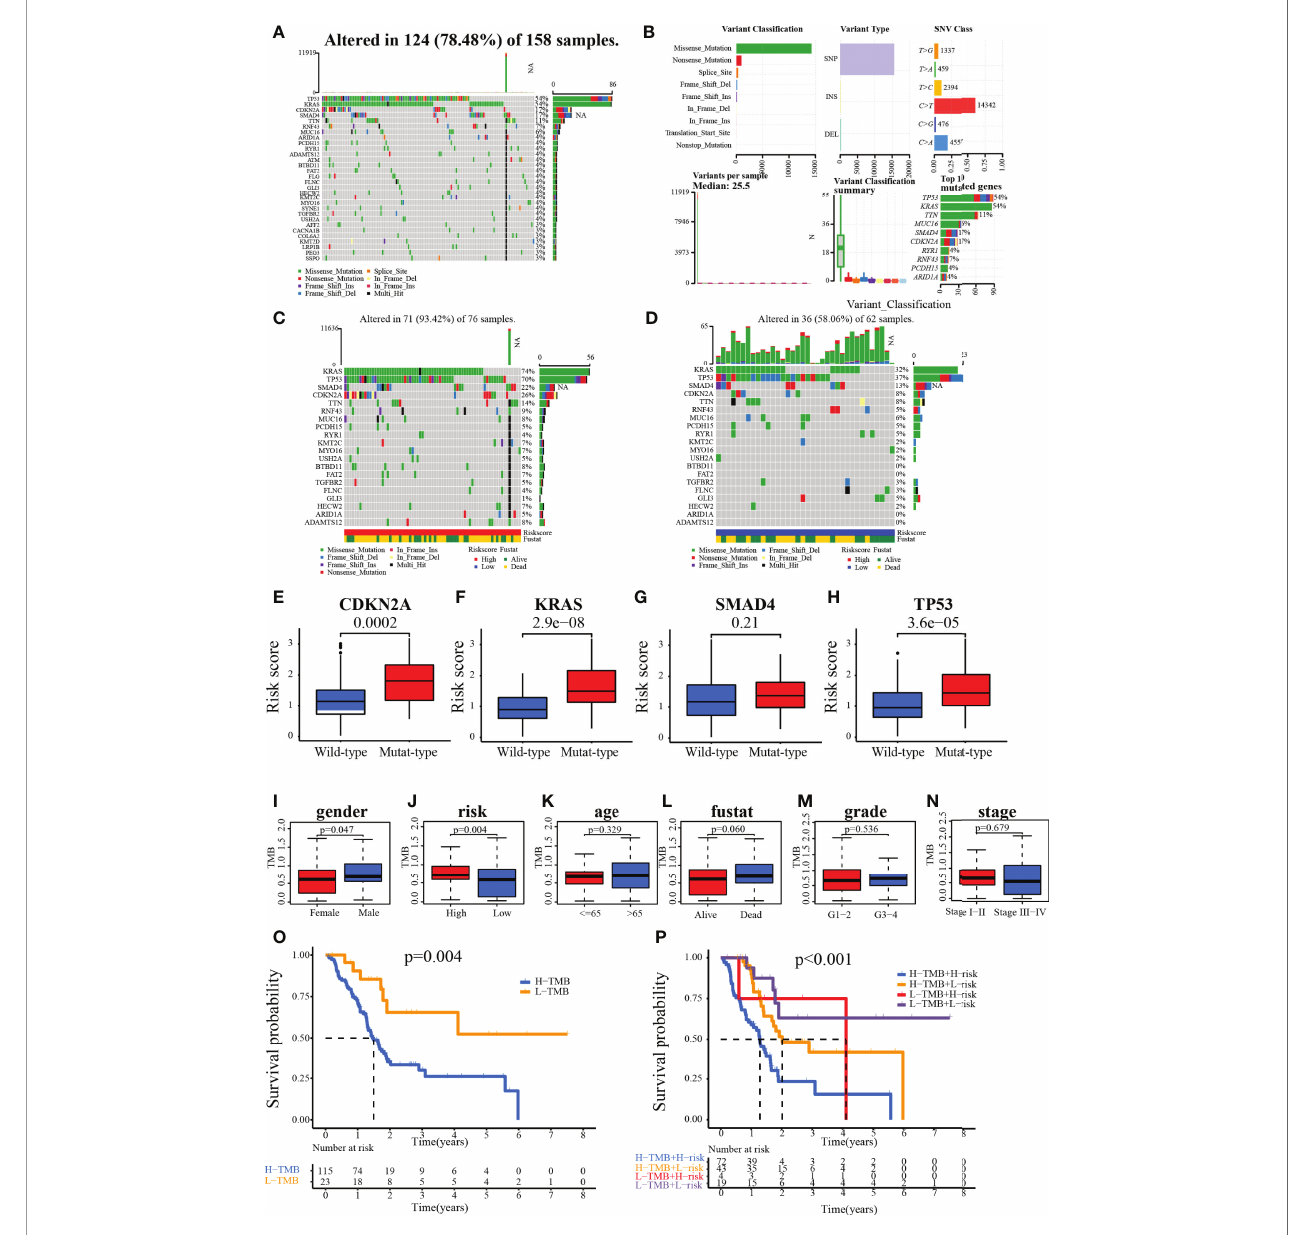
FIGURE 11 | (A, B) Waterfall plot for the TCGA patients. (C, D) Waterfall plot for the patients in the high- and low-risk group. (E – H) Relationship between genes (CDKN2A, KRAS, SMAD4, and TP53) status and risk score. (I – N) The association of clinical characteristics and risk scores with TMB. (O, P) Kaplan – Meier survival analysis of patients with different TMB with/or different